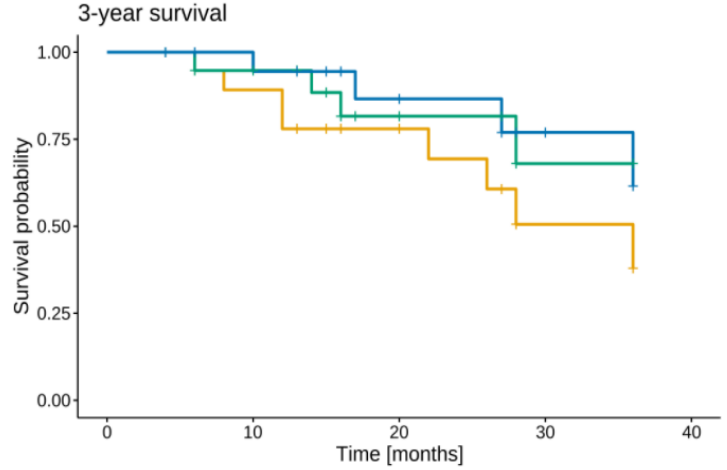
Figure 2. Kaplan – Meier estimates of local control (LC), Distant metastatic free survival (DMFS), and survival (OAS), respectively, for all patients. DMFS =